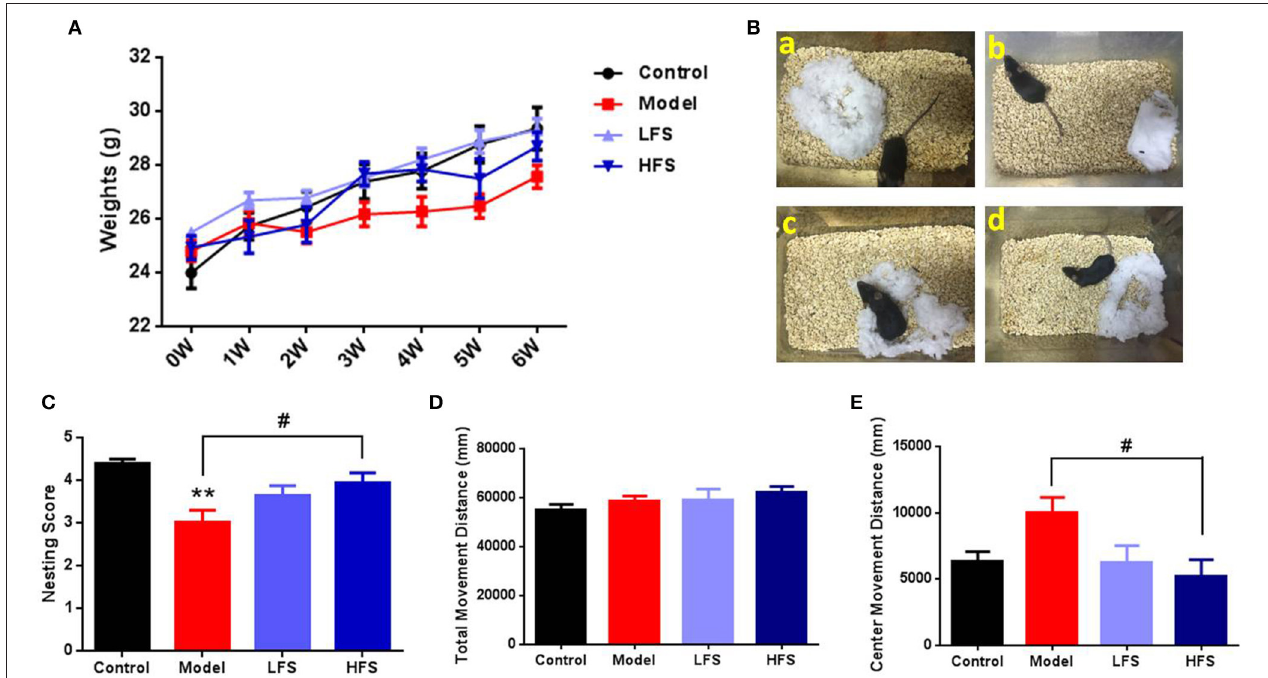
FIGURE 2 | Body weight, nesting, and locomotion are altered by cuprizone and partially rescued by DMS. (A) Weight changes in mice subjected to different treatments. (B) Representative images of nests built by control (a) , model (b) , LFS (c) , and HFS (d) mice. (C) Histogram of nesting scores. (D) Total movement distance in 10min. (E) Center zone movement distance in 10min. Values are expressed as mean ± SEM ( n = 12–15). ** P < 0.01 vs. control group; # P < 0.05 vs. model